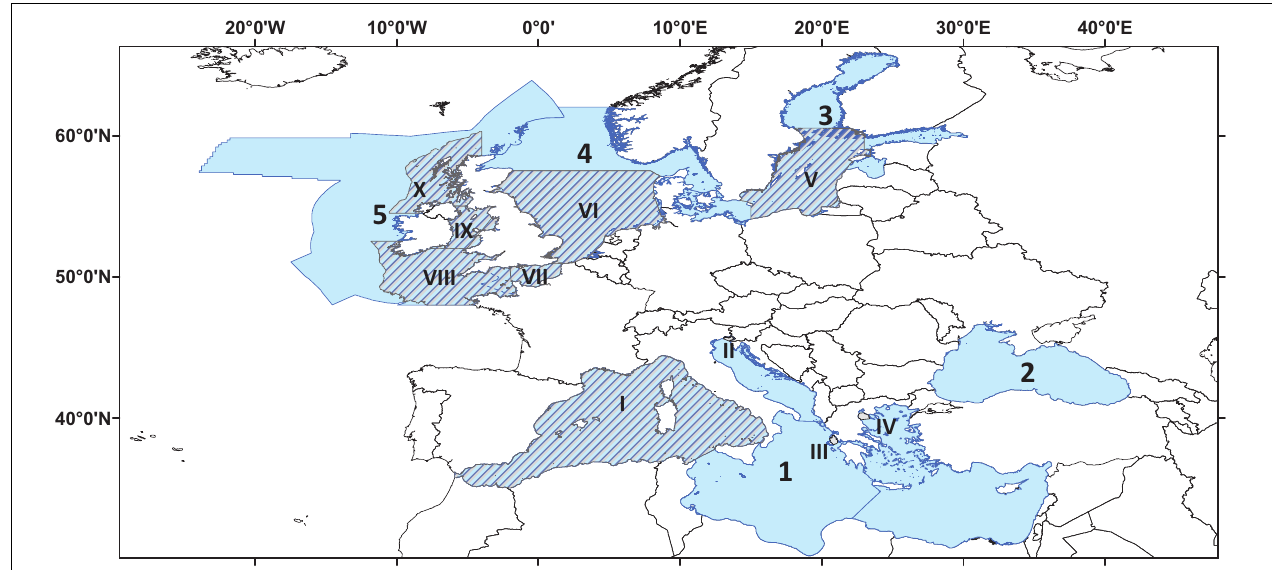
FIGURE 1 | Map showing the location and spatial extent of the 14 ecosystems models included in the analysis. Light-blue background and Arabic numbers correspond to MSFD regions and sub-regions (1 = Mediterranean Sea; 2 = Black Sea; 3 = Baltic Sea; 4 = North Sea; 5 = Celtic Seas) while dashed background and Roman numbers refer to smaller areas within an MSFD region/sub-region (I = Western Mediterranean; II = North-East Adriatic; III = Inner Ionian Archipelago; IV = Thermaikos Gulf; V = Baltic Proper; VI = North Sea; VII = English Channel; VIII = Celtic Sea; IX = Irish Sea; X = West Coast of